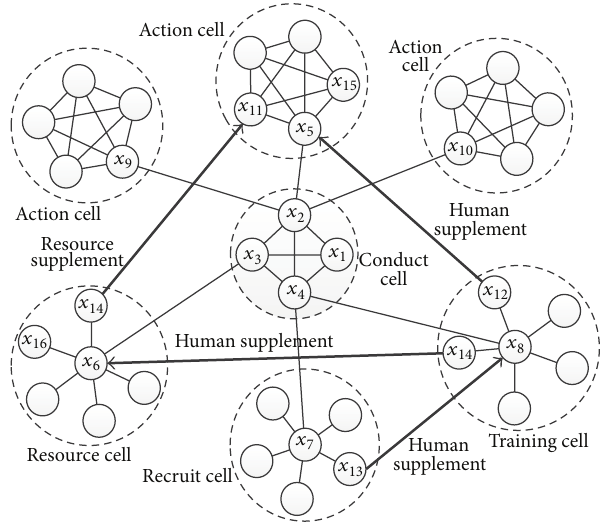
Figure 2: Organizational structural model of terrorist network.